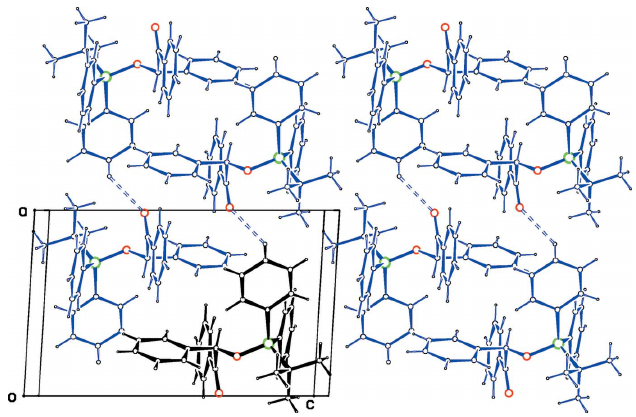
Figure 2 Projection along the b axis for the title compound, tilted by 4 (cid:2) for clarity. The reference molecule is in black. Silicon atoms are green, oxygen atoms red.